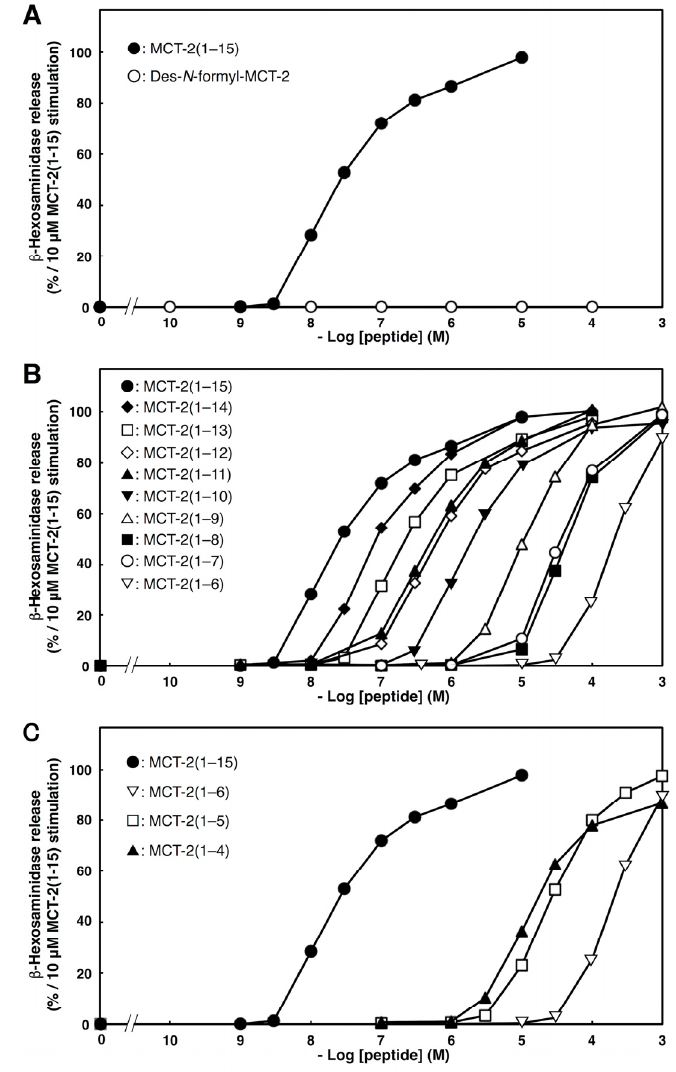
Figure 2. Effects of N-terminal ( A ) or C-terminal ( B , C ) truncations of MCT-2(1–15) on β -hex- osaminidase release by differentiated HL-60 cells. The differentiated HL-60 cells were stimulated by MCT-2(1–15) or its derivatives at 37 °C for 10 min, and the amount of the released β -hex- osaminidase was quantified as described in “Materials and Methods”. The ability of each peptide to induce β -hexosaminidase release is expressed as a percentage of enzyme secretion promoted by 10 μ M MCT-2(1–15). Data are expressed as the mean ± SE of four to six independent experiments. Table 1. Amino acid sequences of MCT-2(1–15) and its C-terminal or N-terminal derivatives and their EC 50 values and Peptide Sequence EC 50 (nM) Maximum Effect (%) a